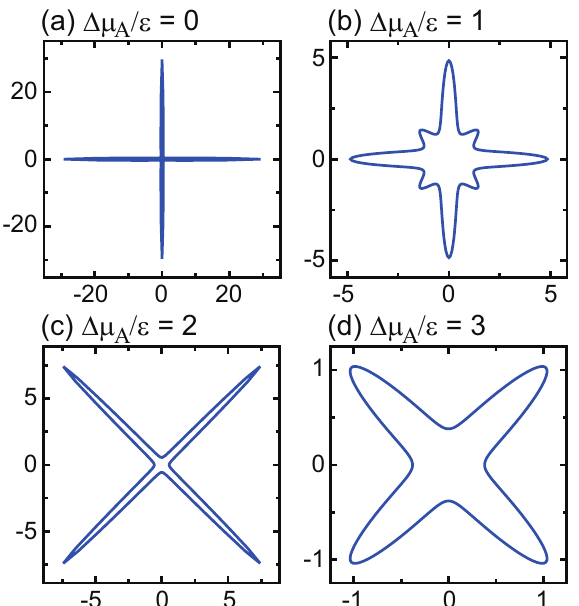
Figure 11. Polar graphs of the interface stiffness calculated using the IPW method [75,76] based on the 2D lattice gas model. ∆ µ A / (cid:101) = ( a ) 0.0, ( b ) 1.0, ( c ) 2.0, and ( d ) 3.0. The values have the unit J ( = (cid:101) /2). k B T / (cid:101) = 0.2. These figures are reprinted from Figures 3 and 4 in Ref. [40]. Copyright (C) 1992 The Physical Society of